Question: What caption would you write for this figure?
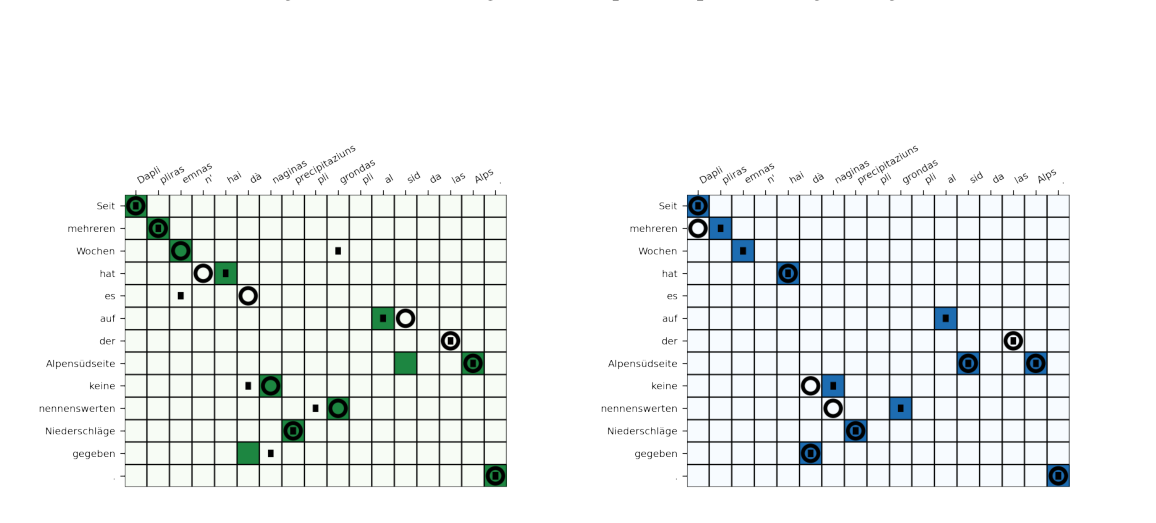
Answer: Example for aligning a sentence with differing word order. Green: eflomal (boxes) vs. SimAlign (circles); Blue: awesome-align (circles) vs. after fine-tuning (boxes). The dark green/blue squares represent the gold alignments.